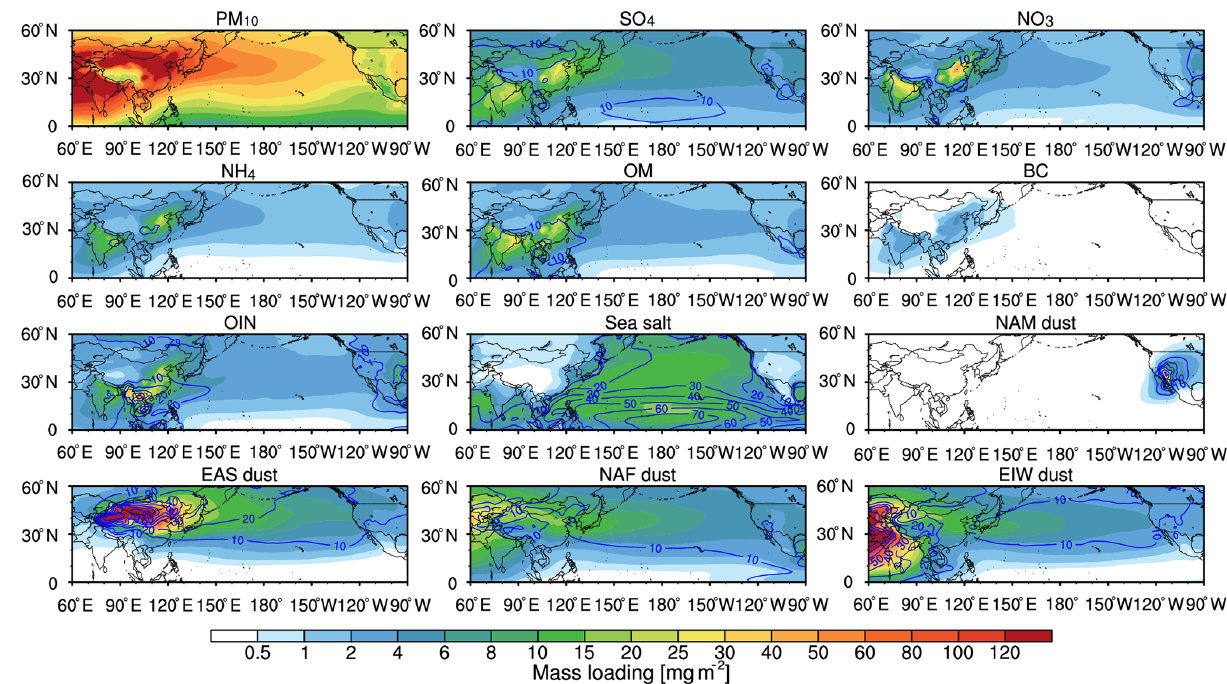
Figure 3. Spatial distribution of aerosol composition column mass loading from WRF-Chem averaged for 2010–2014. The trans-Pacific transport aerosol mass spatial distribution is denoted by PM 10 and the dust from North America, East Asia, north Africa, and elsewhere in the world is denoted by NAM dust, EAS dust, NAF dust, and EIW dust. Contour lines (blue solid line) denote the percentage contribution (%) of the corresponding aerosol composition to total aerosol column